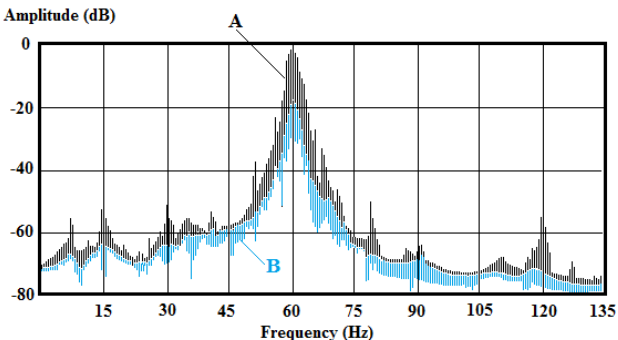
Fig. 6. Block-diagram of measurement diagnostic parameters for the diesel engine installation.